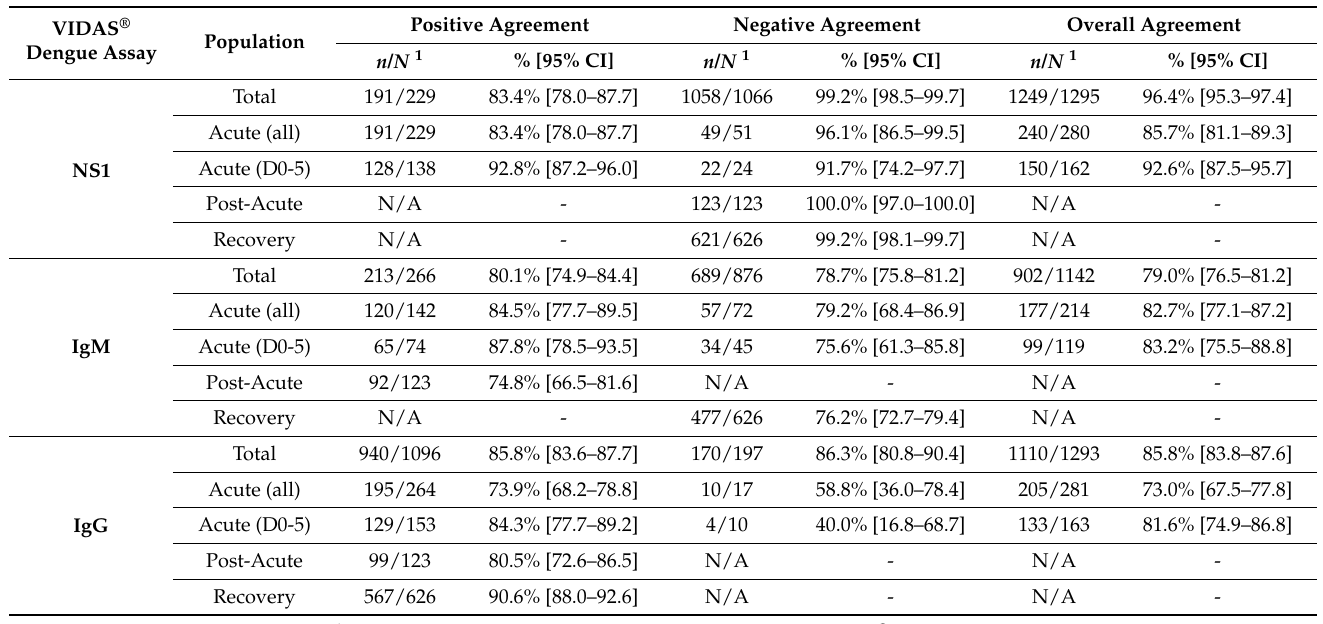
Table 10. Concordance of the VIDAS ® dengue assays with the respective competitor ELISA, in the global population and per stage of DENV